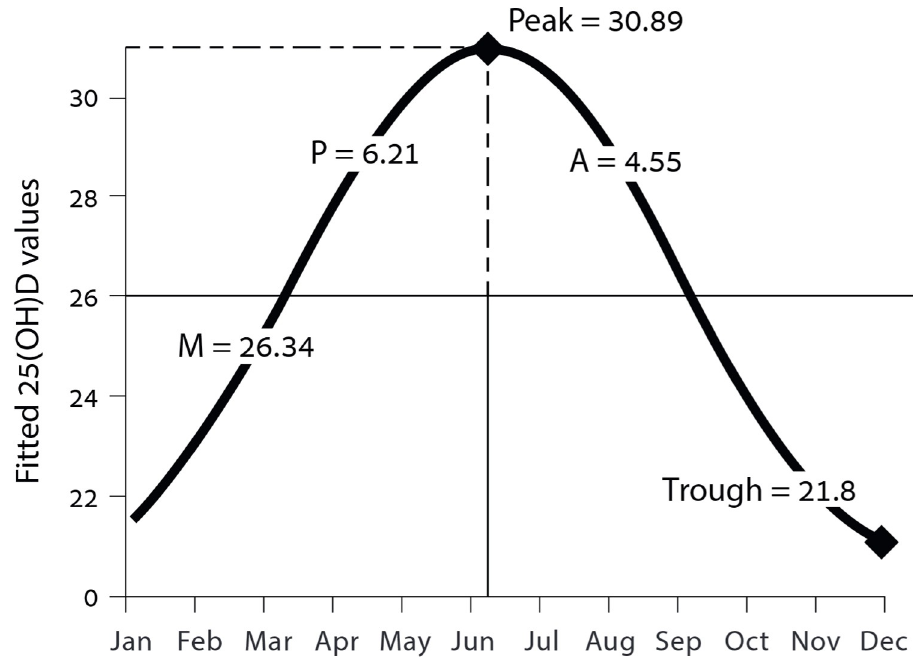
Fig 1. The cosinor 25(OH)D model for all months. The predicted 25(OH)D mean value of each month through the annum can be extracted from the graph. This figure demonstrates the predicted peak of 25(OH)D concentration in June and the expected trough in December. The predicted 25(OH)D mean value of each month can be utilized to predict the 25(OH)D for the hospitalization month of any given patient (Eq 3). M = mesor, A = amplitude, P =